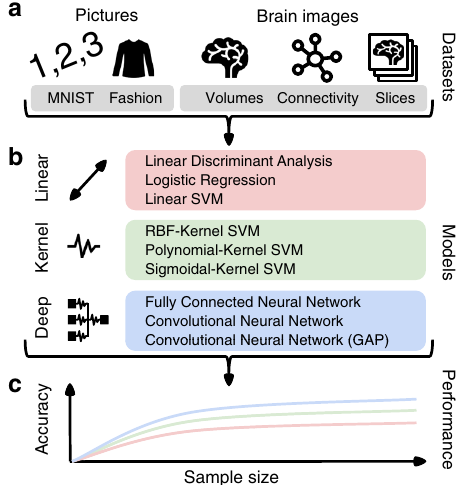
Fig. 1 Work fl ow and experimental design. We directly compared the properties of machine learning datasets to brain-imaging datasets based on performance curves of three classes of predictive models. a Well- understood benchmark datasets from the machine learning community were elected to replicate previous results and serves as a reference point for the scaling behavior in relation to imaging neuroscience: the MNIST images were to be classi fi ed into different handwritten digits and Zalando ’ s Fashion images were to be classi fi ed into different types of clothing. Several representations of brain structure and function were obtained from the UKBiobank resource: region volumes and whole-brain slices from structural MRI, as well as functional connectivity strengths from resting-state functional MRI. Brain-image data were used to predict the subjects ’ age and sex in 10 subgroups to match the ten target categories of MNIST and Fashion. b Prediction performance for each dataset was pro fi led using predictive models that have capacity for successively increasing predictive power: linear models (red tone), shallow-nonlinear kernel SVMs (green tone), and deep-nonlinear neural network algorithms (blue tones). c For each combination of dataset and model, we systematically varied the number of data points available for the training the model. The resulting empirical estimates of sample complexity allow to extrapolate conclusions to always larger sample